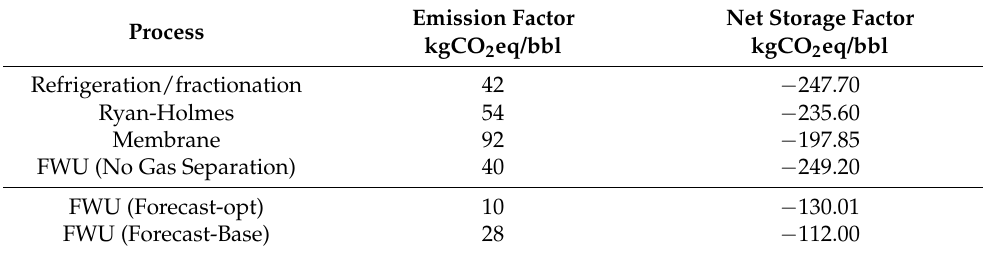
Table 8. Summary of emission factors for Task 1 and Task